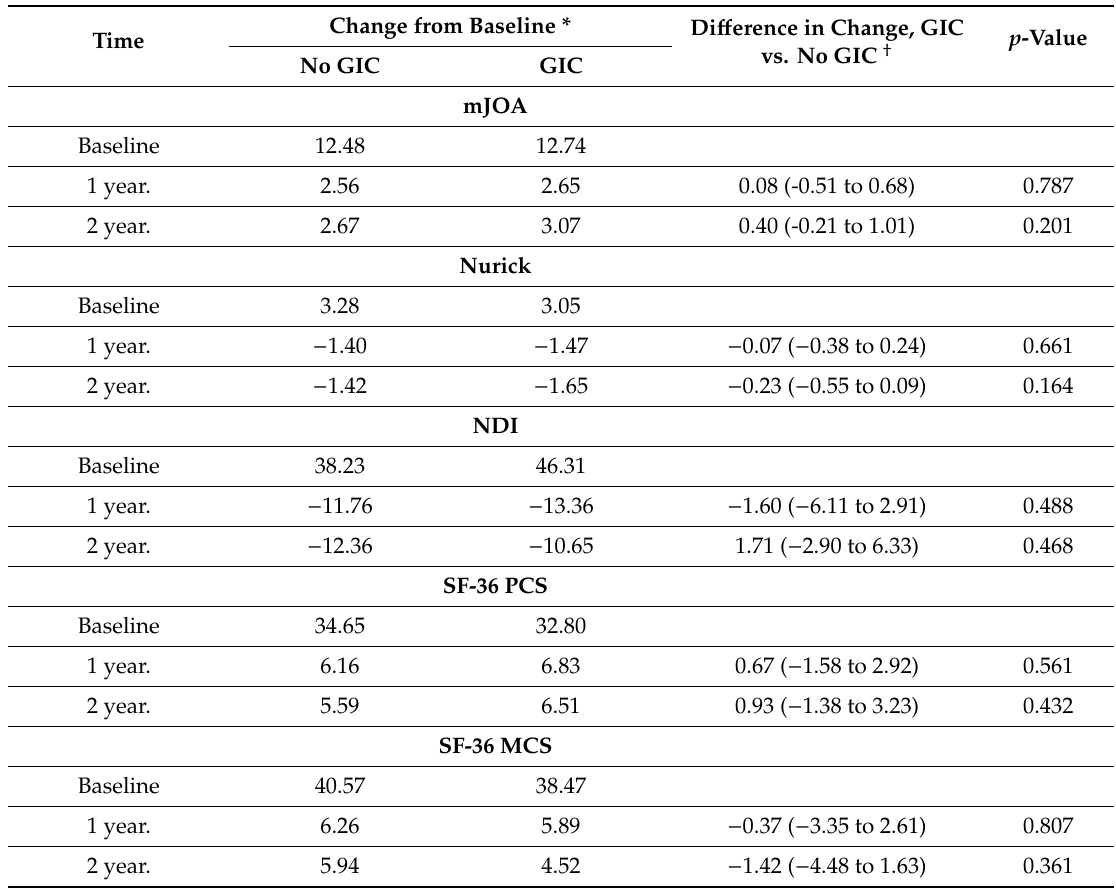
Table 3. Outcomes comparing GIC and non-GIC subgroups using linear mixed e ff ects